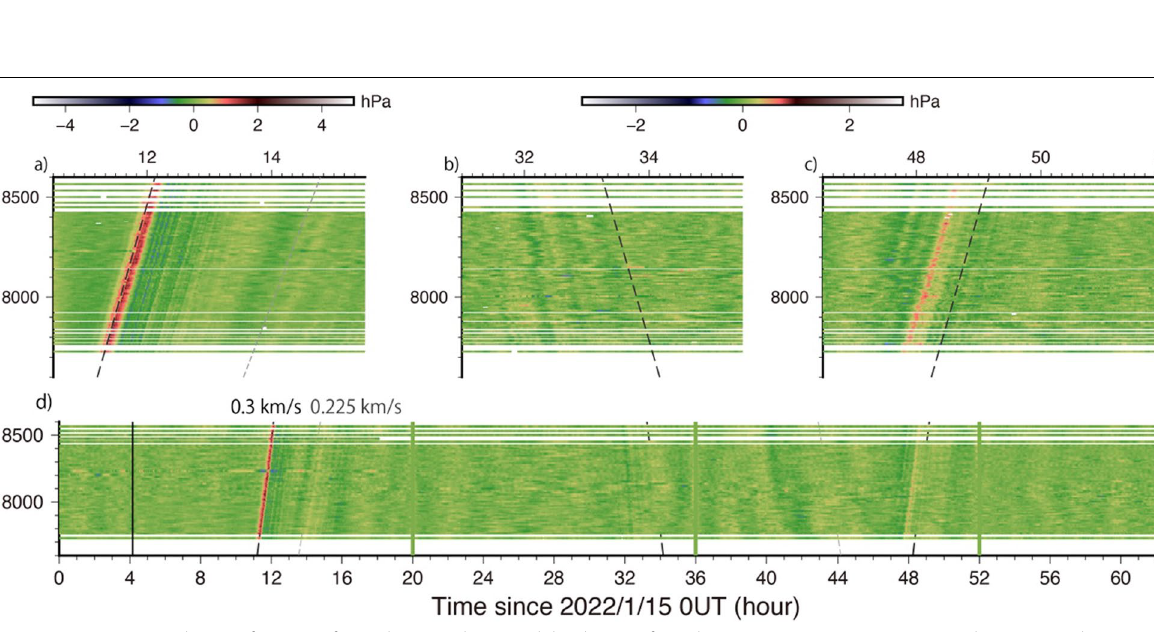
Fig. 3 Pressure anomalies as a function of time (horizontal axis) and the distance from the Hunga Tonga-Hunga Ha’apai volcano (vertical axis, unit km), obtained as residuals from best-fit degree-9 polynomials over the four time intervals (boundaries shown as thick vertical bars in green at 20, 36, and 52 h). The left and right color bars apply for a , d and b , c , respectively. The expected passage times calculated using the two velocities 0.300 km/s (LW) and 0.225 km/s (IGW) are indicated with thick and thin broken lines, respectively. The three panels in a – c show the close-up views of the time windows including the three passages of